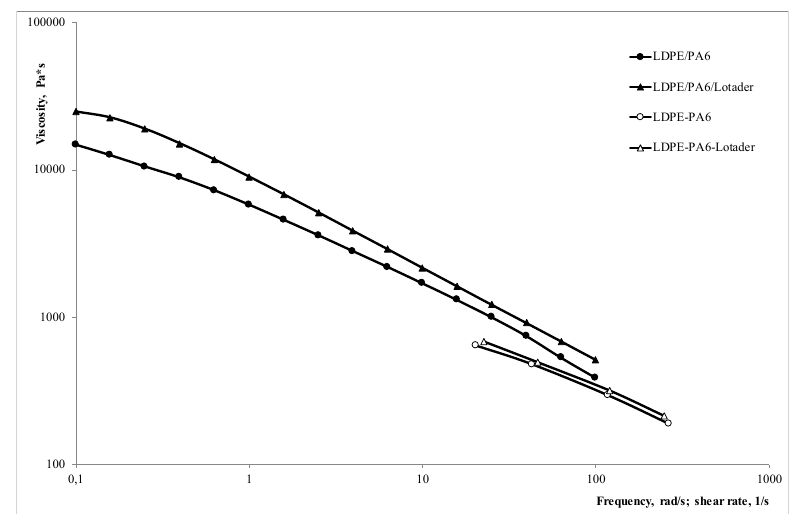
Figure 1. Flow curves of the compatibilized and uncompatibilized blend (solid points have been measured in the rotational rheometer, while open points in capillary viscometer). LDPE: low density polyethylene.